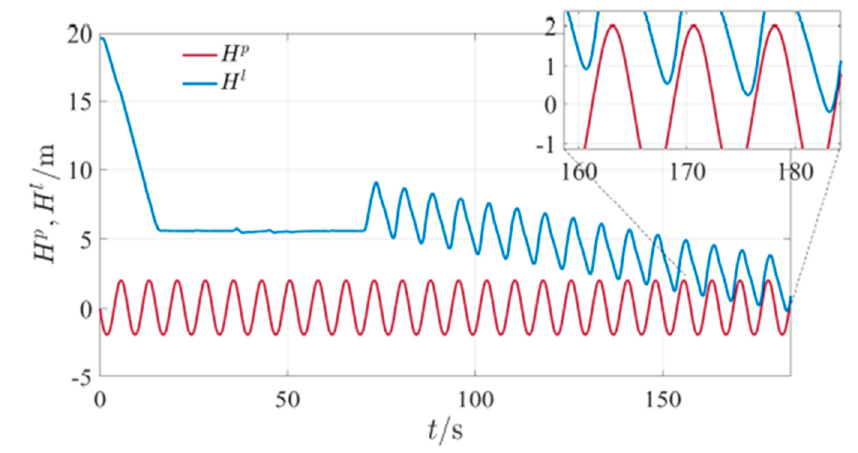
s = = . Figure 45. The evolution of H p and H l vs. time when A w = 4 m, T w = 7.5 w